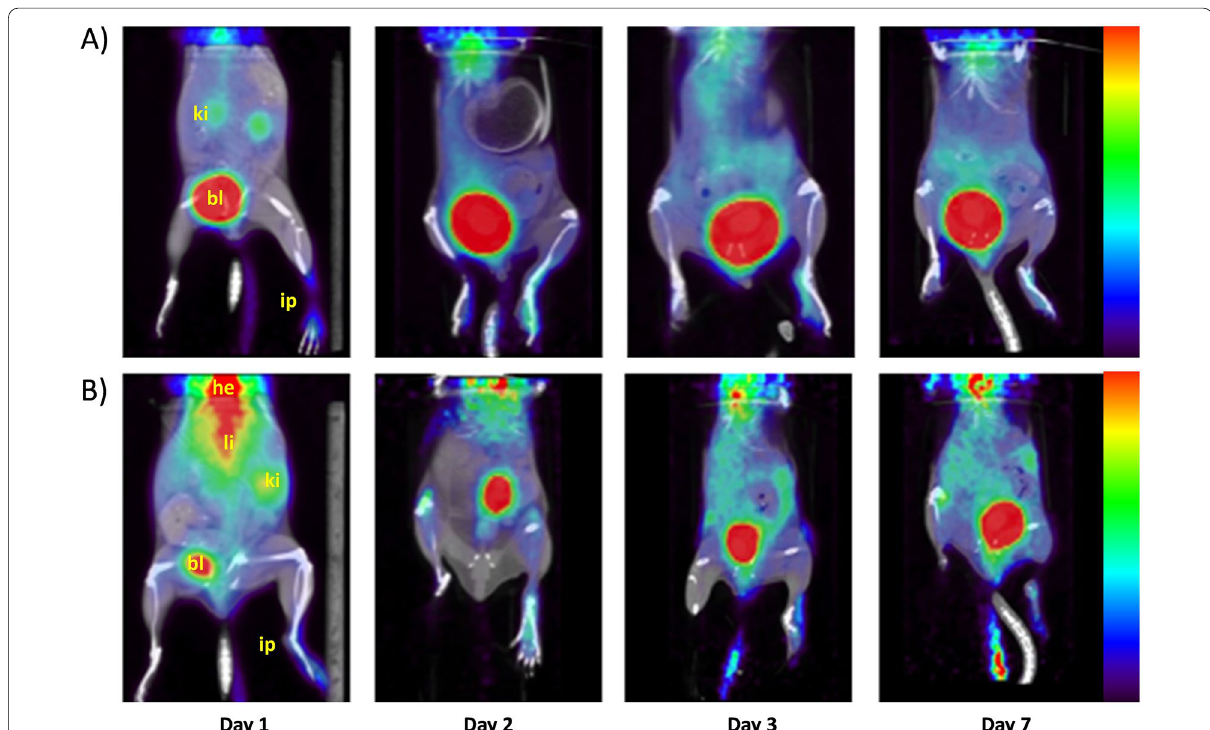
Fig. 7 PET/CT scan of BALB/c mice injected with A [ 68 Ga]Ga‑4HMSA and B [ 68 Ga]Ga‑citrate with the left paw inflamed at days 1, 2, 3 and 7 post‑CFA administration and at 15 and 45 min post‑tracer injection, respectively. [ 68 Ga]Ga‑4HMSA and [ 68 Ga]Ga‑citrate uptakes are similar in the inflamed paw (ip) and decreased steadily from Day 1 to Day 7. Lower accumulation in healthy tissues was obtained with [ 68 Ga]Ga‑4HMSA. Legend: blader (bl), injected paw (ip), heart (he) liver(li), kidneys (ki)